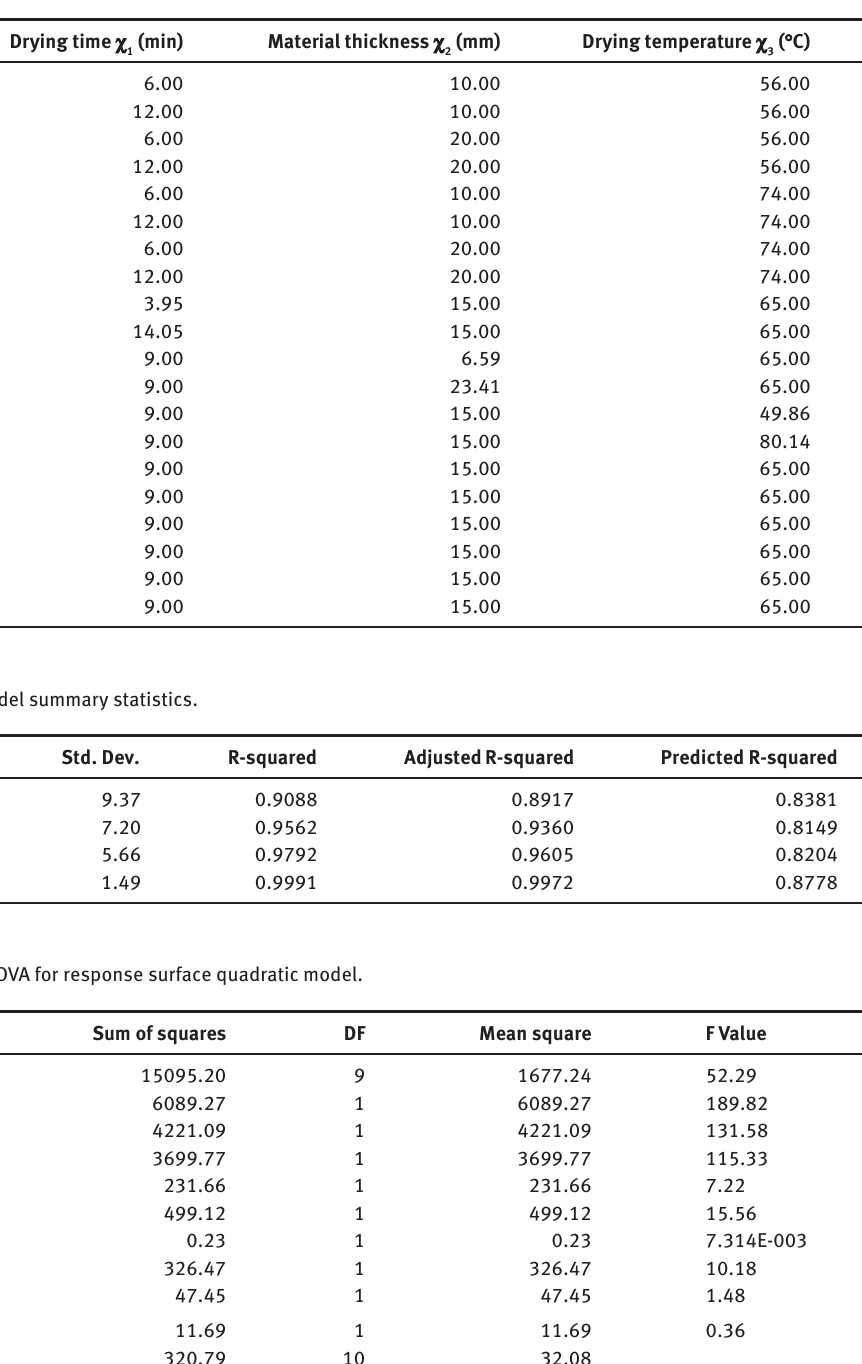
Table 2: Experimental design matrix and results.